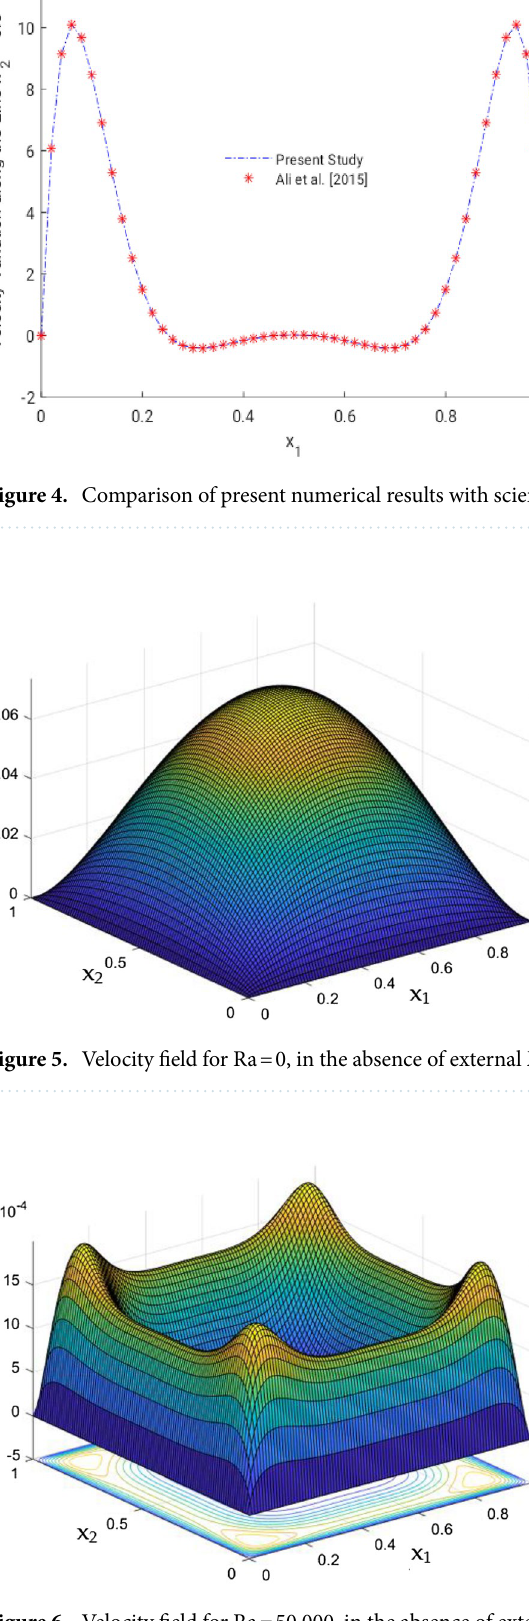
Figure 6. Velocity field for Ra = 50,000, in the absence of external